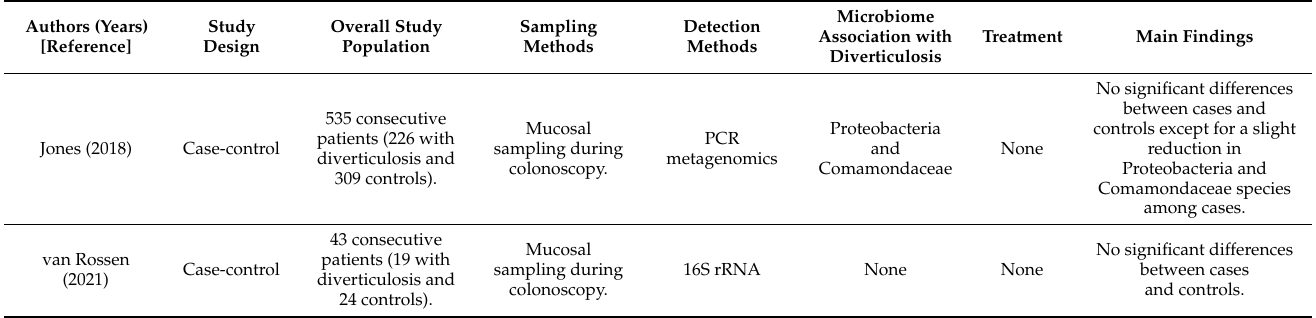
Table 1. Microbiota characterization in